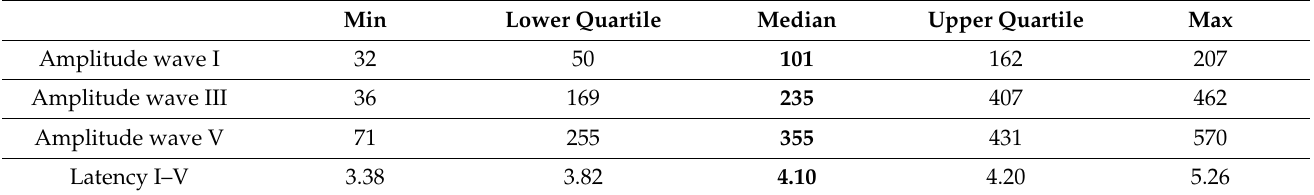
Table 2. Click-evoked auditory brainstem response amplitudes and wave I–V latency at 80 dB nHL (n = 10, except for wave III, n =